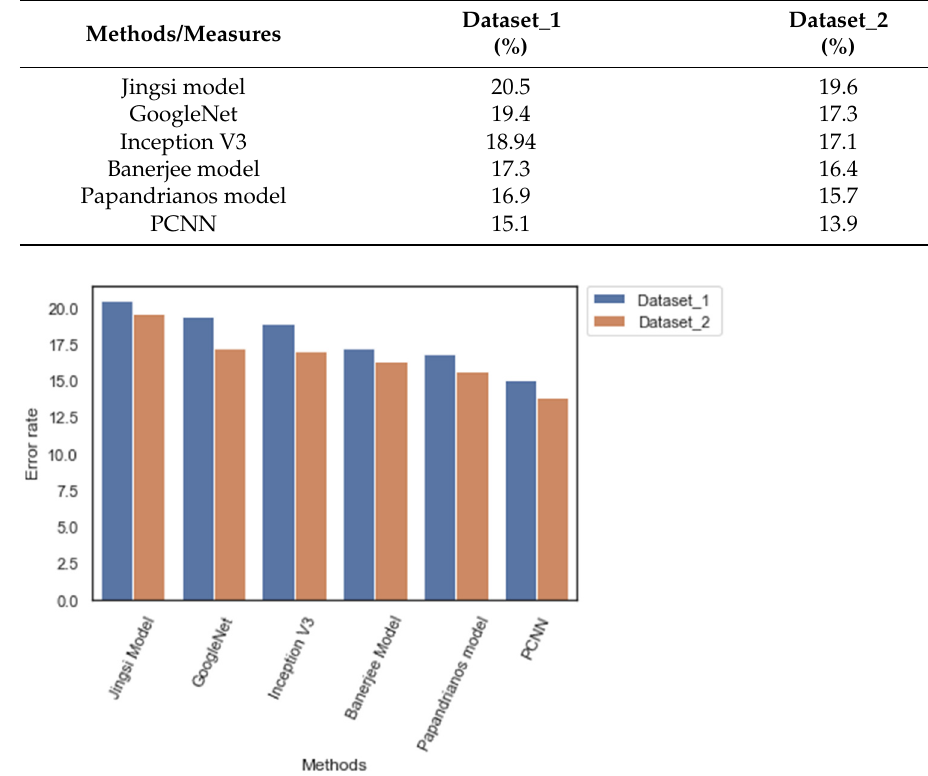
Table 10. Error rates of CNN for Dataset_1 and Dataset_2.